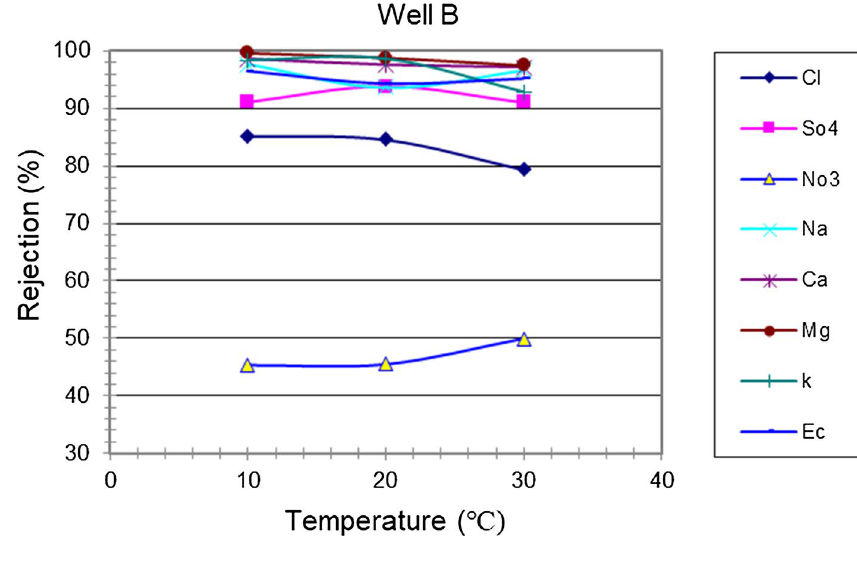
Fig. 10 Rejection rate of ions versus temperature (pressure: 12